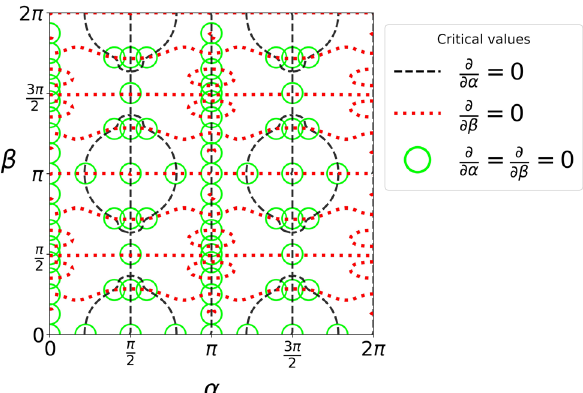
∂ . ( b ) Contour for ∂ α